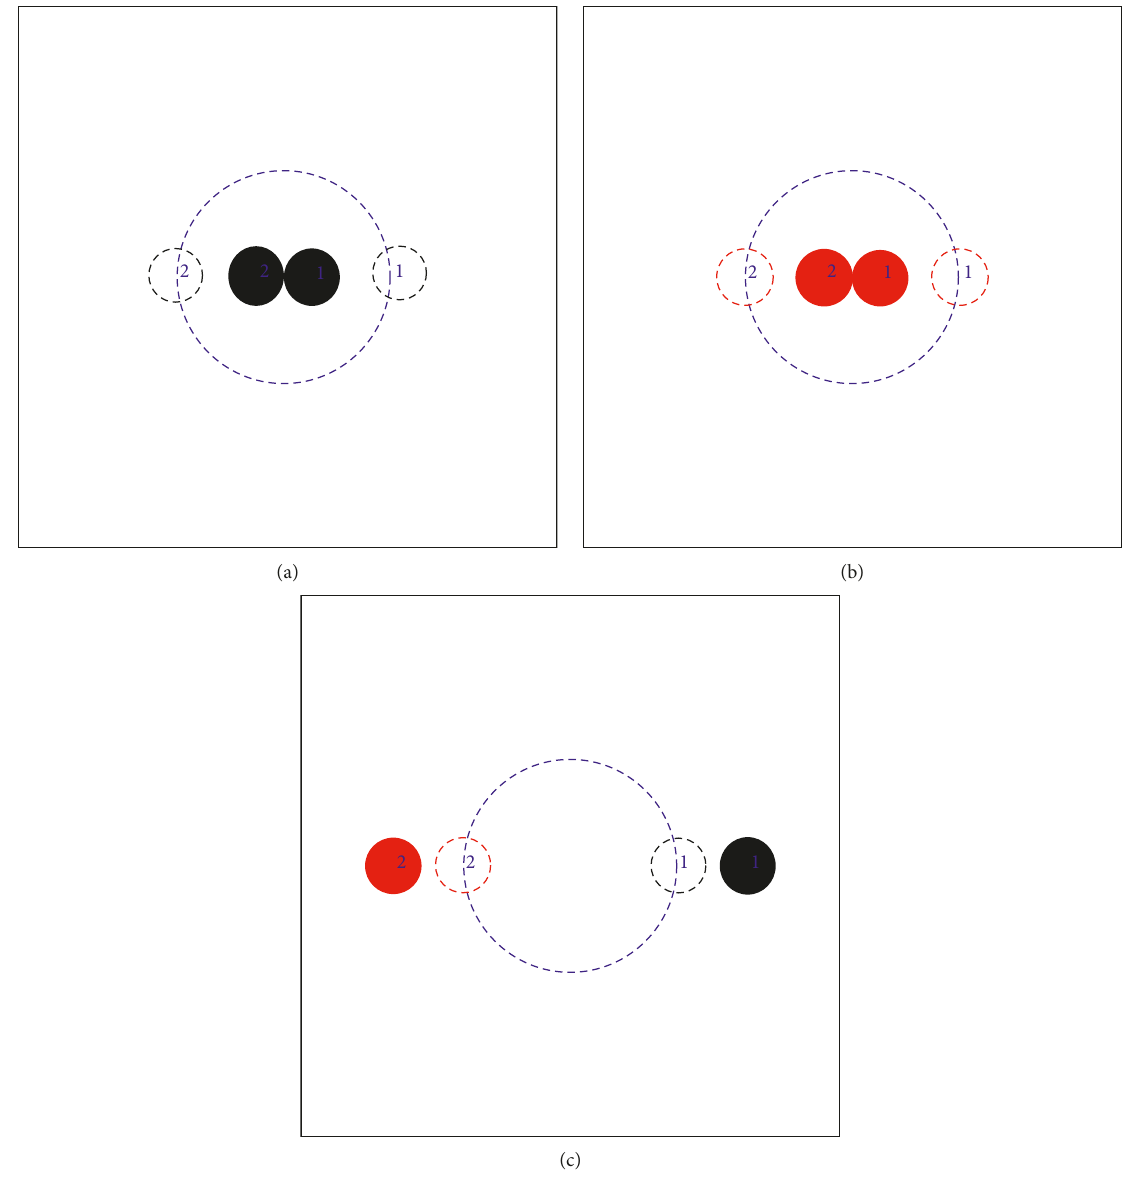
0 (cid:31) 0 in a uniform DC electric field with E (cid:31) 1kV/m